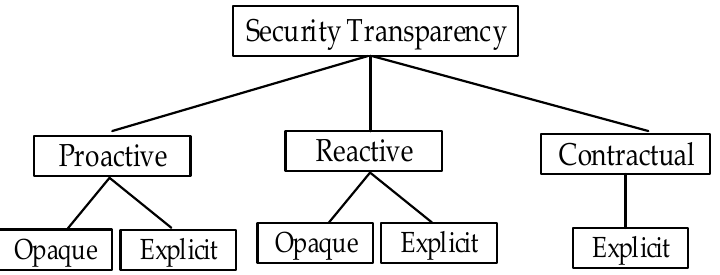
Figure 3. Relationship between transparency categories and deployment practices.